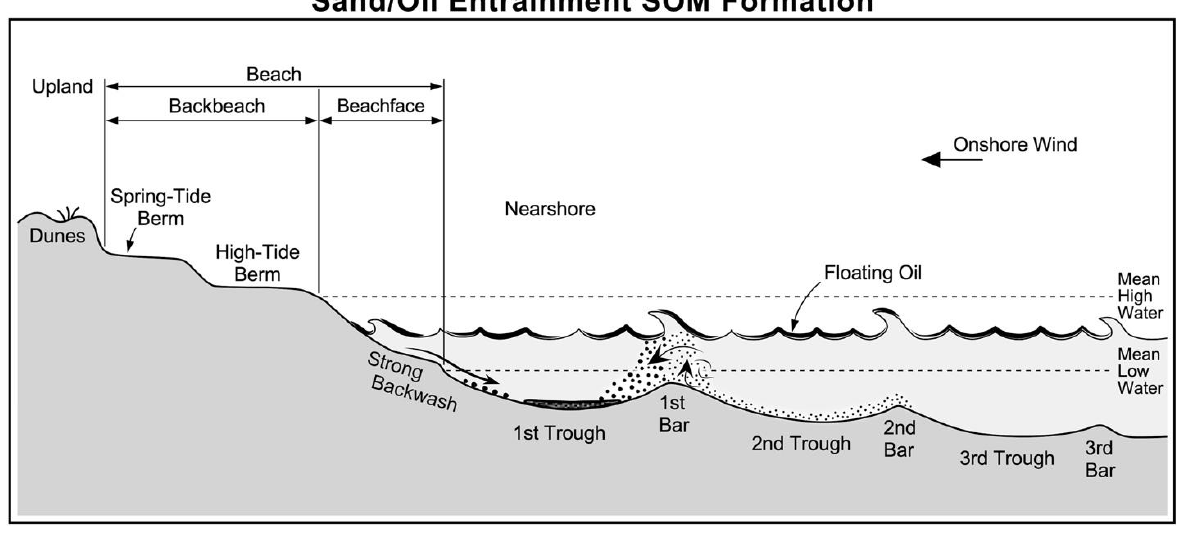
Figure 1. Schematic of the offshore entrainment process during SOM formation where sand and floating oil are suspended together by breaking waves over offshore bars, then accumulate in the trough where the energy is lower. There can also be the erosion of oiled sand from the adjacent beach.